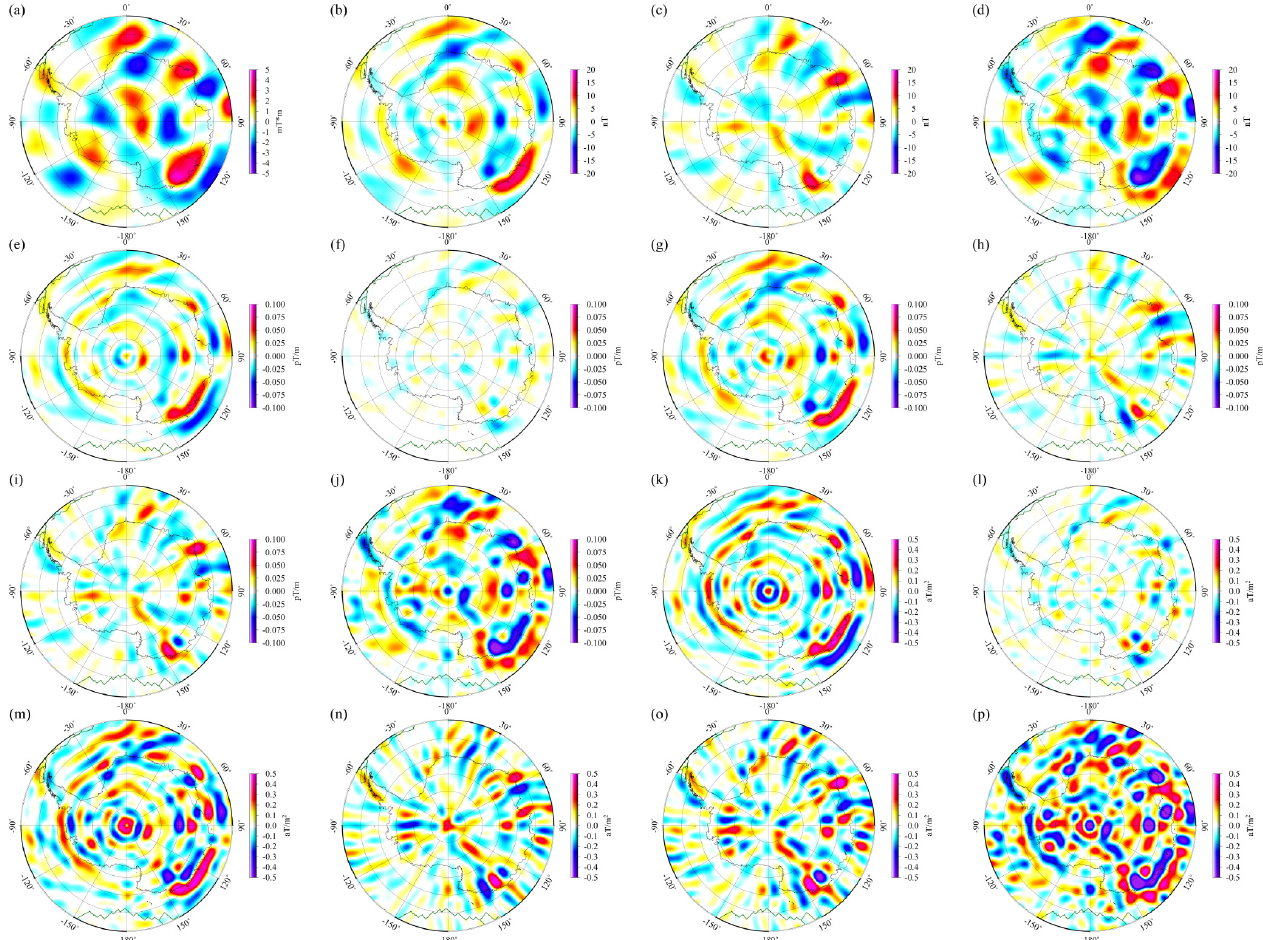
Figure 2. Lithospheric magnetic potential, magnetic vector and its gradient fields and third-order partial derivatives of the magnetic potential field around the South Pole (150 ◦ ≤ θ ≤ 180 ◦ ) at the altitude of 300km as defined by the lithospheric magnetic field model GRIMM_L120 (version 0.0) (Lesur et al., 2013) for spherical harmonic degrees 16–90. (a) is magnetic potential ( V ) , (b) , (c) and (d) are three components ( B x , B y and B z ) of the magnetic vector; (e) , (f) , (g) , (h) , (i) and (j) are six elements ( B xx , B xy , B xz , B yy , B yz and B zz ) of the magnetic gradient tensor; (k) , (l) , (m) , (n) , (o) and (p) are six elements ( B xxz , B xyz , B xzz , B yyz , B yzz and B zzz ) of third-order partial derivatives of the magnetic potential field, respectively. The dark green lines are the plate boundaries by Bird (2003). All maps are shown in polar stereographic